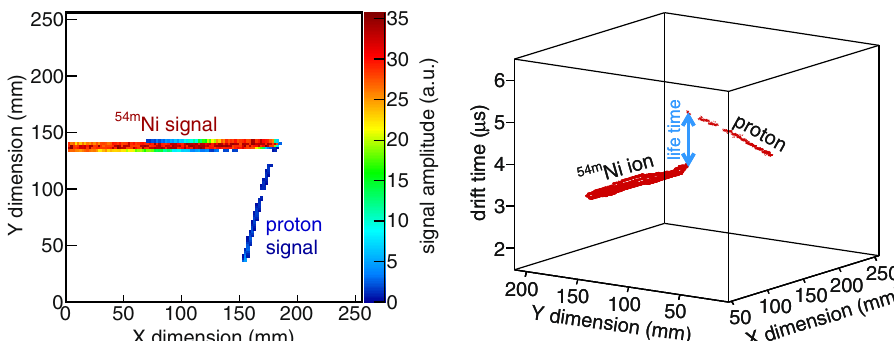
Fig. 2 Example of a 54m Ni implantation followed by its proton radioactivity. The left plot shows the amplitude of the ionization signal measured on the ( X , Y ) pads of the collection plane of ACTAR TPC: the proton track can be distinguished from the ion track. In the right plot, the signal is presented in the 3D space, where the vertical coordinate is the drift time of the signal: it can be converted to the Z dimension by means of the drift velocity of the signal. The vertical gap between the two tracks is due to the decay time of the isomer: the proton is emitted while the ionization electrons created by the ion have already started to drift.